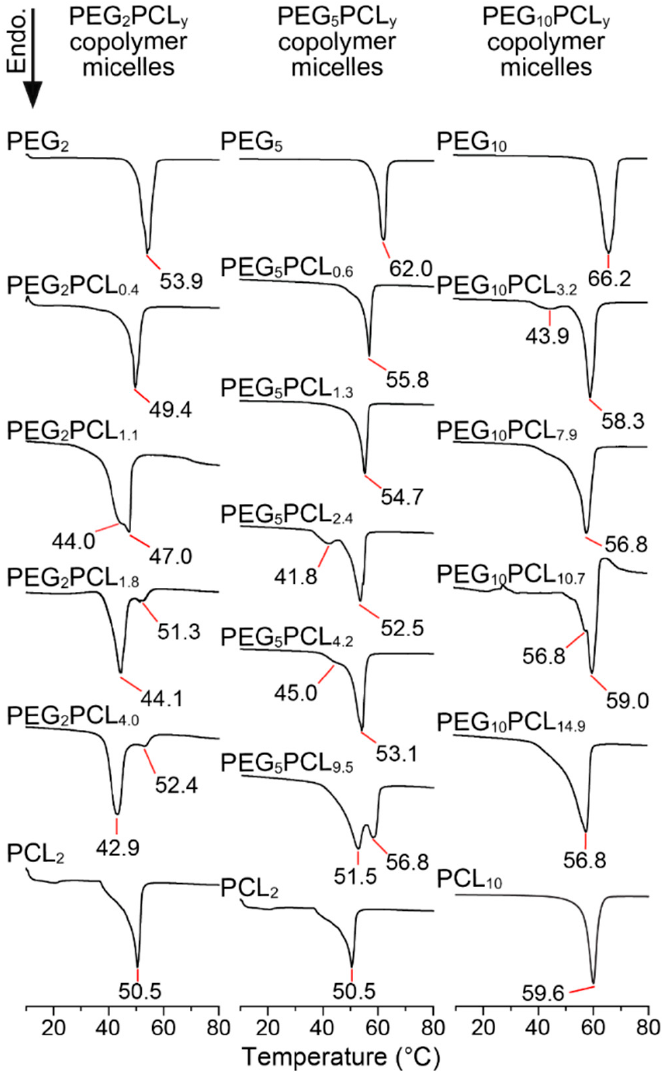
Figure 7. Representative DSC thermograms of the PEG and PCL homopolymers, and PEG 2 PCL y , PEG 5 PCL y , and PEG 10 PCL y copolymer micelles (lyophilised powder), showing the first heating profiles (ramp rate 10 °C/min).